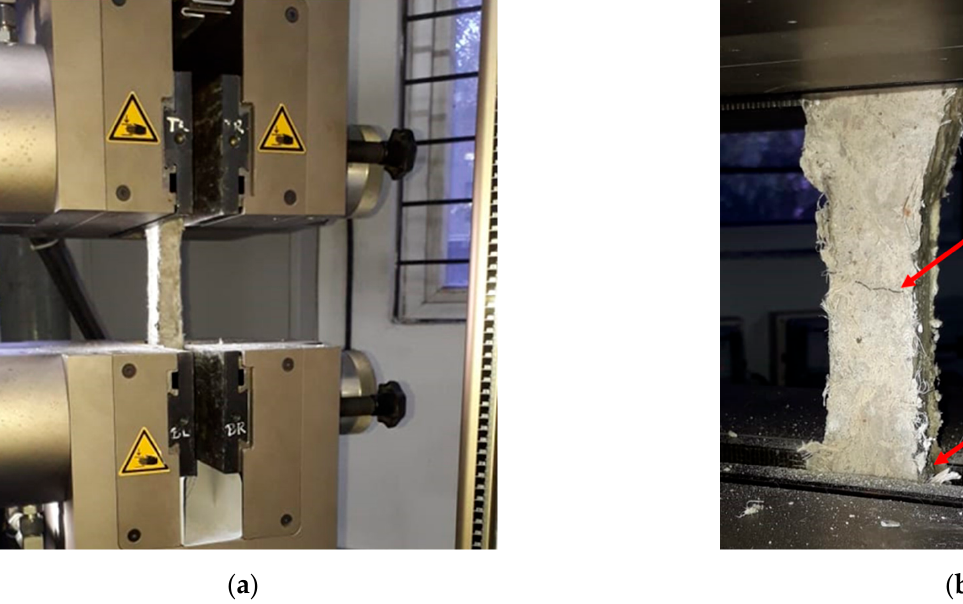
Figure 3. Tensile testing of ECC coupons. ( a ) Test Setup, ( b ) Failure Mode.